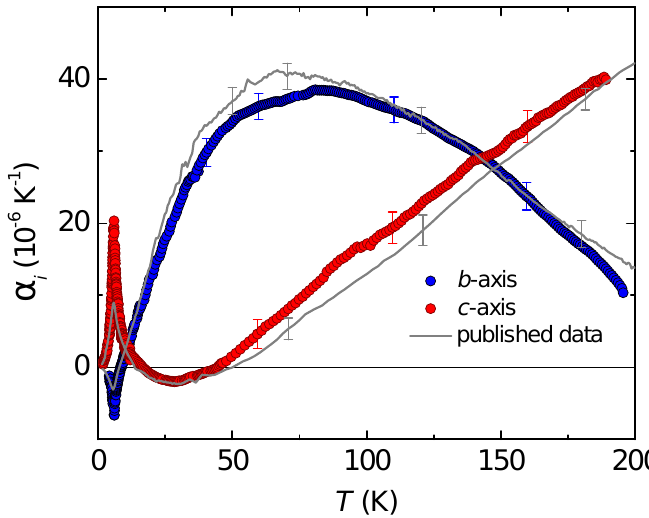
Figure 1. Overview of the coefficients of thermal expansion for κ -(BEDT-TTF) 2 Cu 2 (CN) 3 single crystal MP 1049#2 (symbols) measured along the in-plane b - and c -axis for T ≤ 200 K. The solid gray line corresponds to data for single crystals from batch KAF 5078 reported previously by Manna et al.